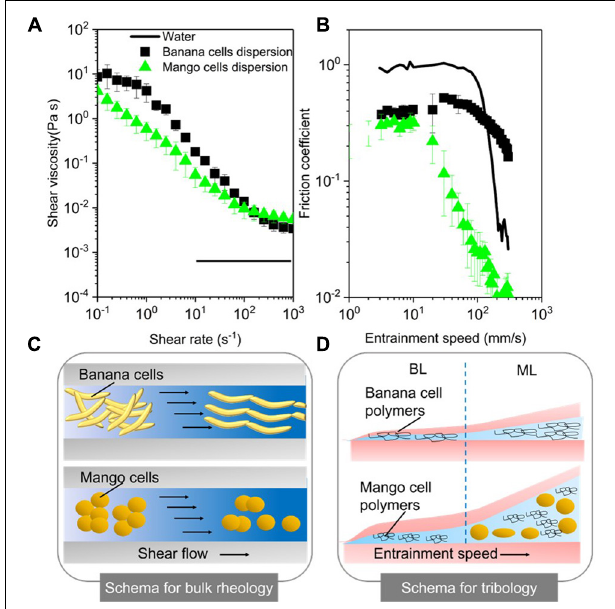
FIGURE 4 | Apparent viscosities as a function of shear rates (A) and friction coefficients as a function of entrainment speeds (B) for mango and banana cell suspensions with respective schematics displayed for rheology (C) and tribology phenomena (BL, Boundary lubrication regime; ML, mixed lubrication regime) (D) . MilliQ water was used as a control in both rheology and tribology experiments. Error bars represent the standard deviation of at least three